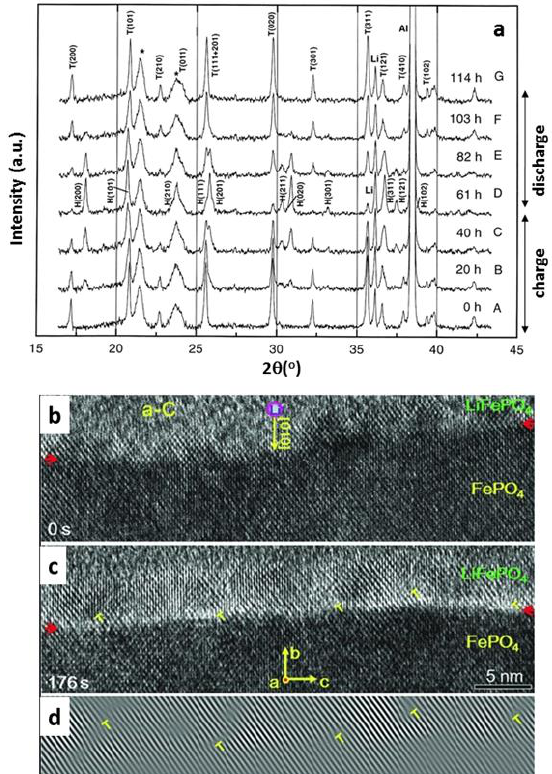
Figure 1. ( a ) XRD spectra collected during the first galvanostatic cycle between 4.0 and 2.9